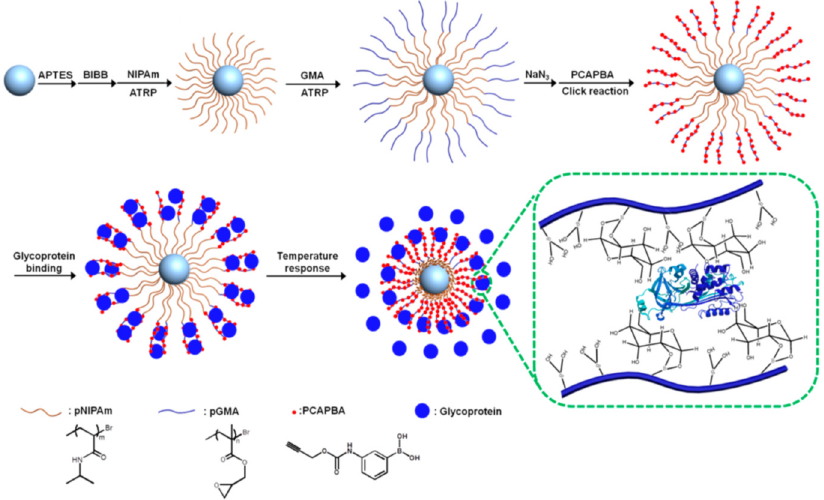
Figure 8. Preparation of Si@pNIPAm-b-pBA core-brush nanocomposite via the combination of SI-ATRP with CuAAC click reaction and the schematic of glycoprotein binding to the boronic acid- functionalized polymer brushes. Reprinted with permission from reference [129].